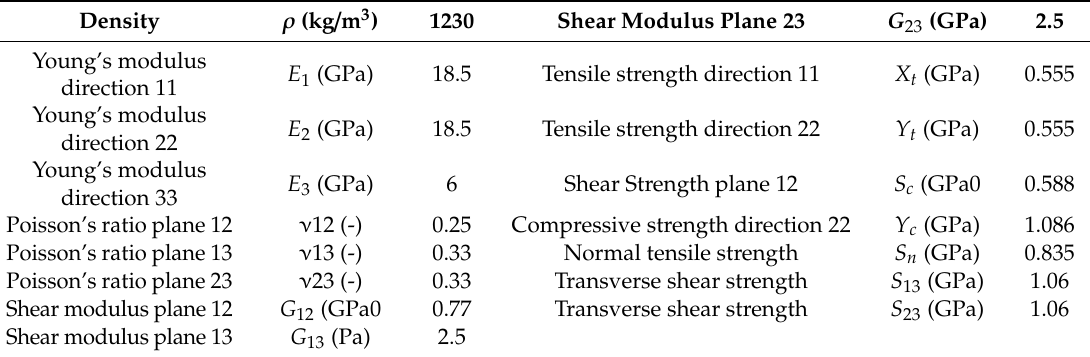
Table 1. Mechanical properties of aramid composite used for the helmet shell.